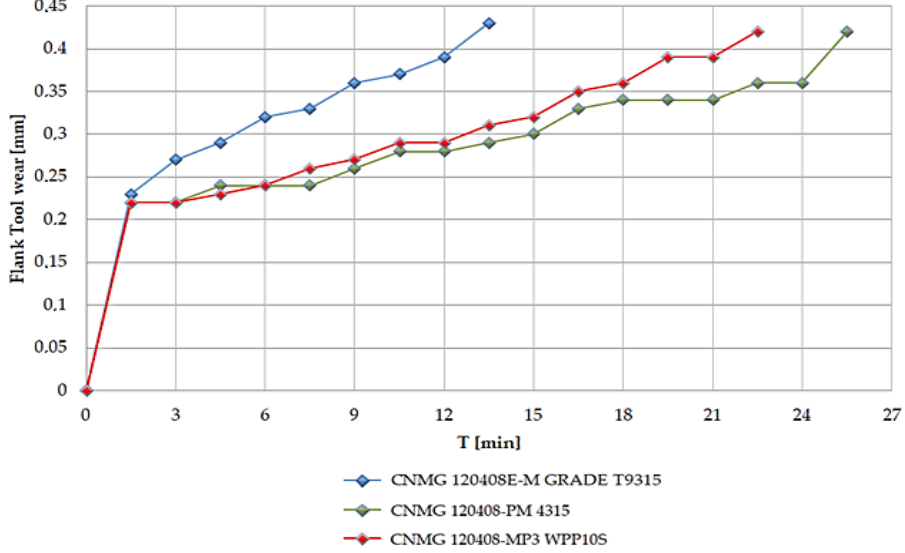
Figure 6. Flank wear ( VB max ) progression of cutting investigated cutting inserts for 1.6582 steel according to EN 10027-2, v c = 120 m · s − 1 . WPP10S board with a time T = 22.5 min. CNMG 120408-MP3 WPP10S cutting